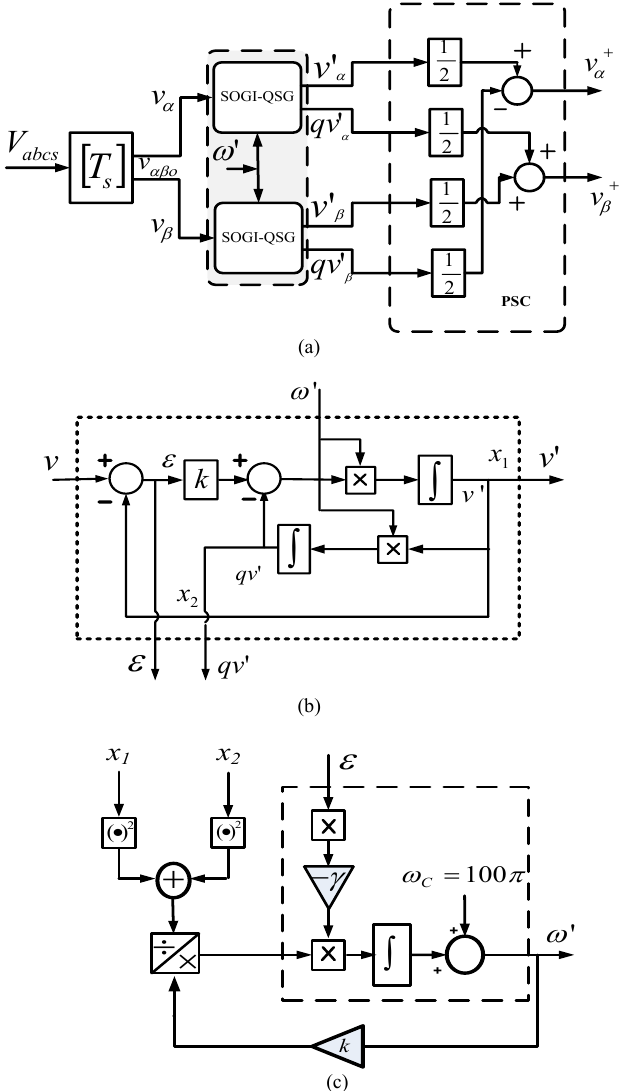
Fig. 1. Basic structure of DSOGI-FLL: (a) abc to α + β + computation(b) Standard SOGI-QSGs and (c)